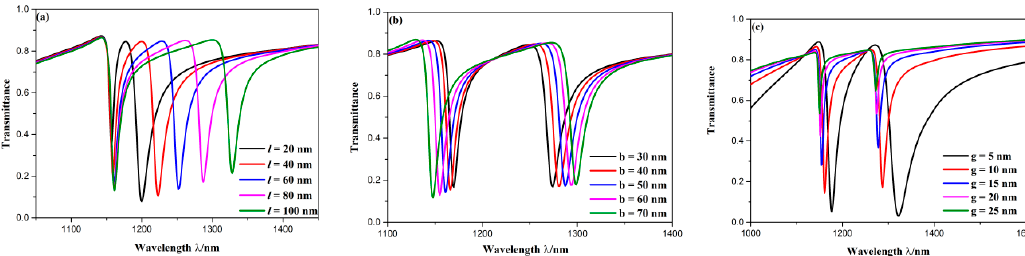
Figure 7. Transmission spectra for ( a ) diverse length of stub on CRCS; ( b ) diverse width of stub on CRCS; ( c ) diverse coupling gap.